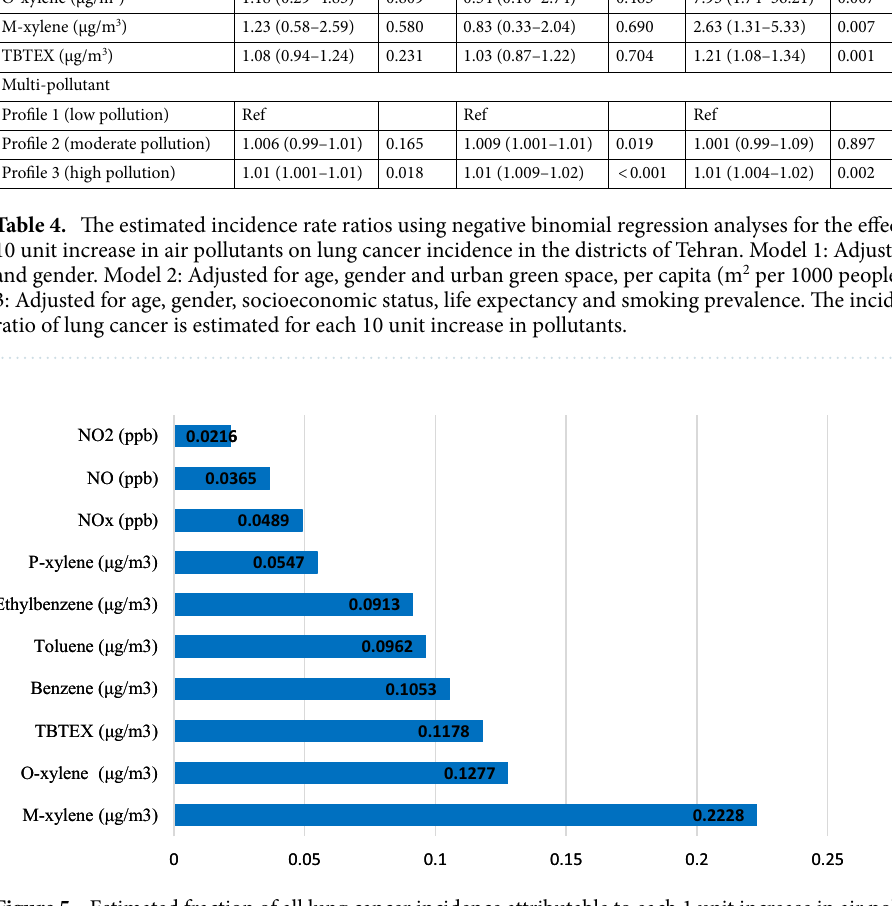
Figure 5. Estimated fraction of all lung cancer incidence attributable to each 1 unit increase in air pollutants in Tehran in